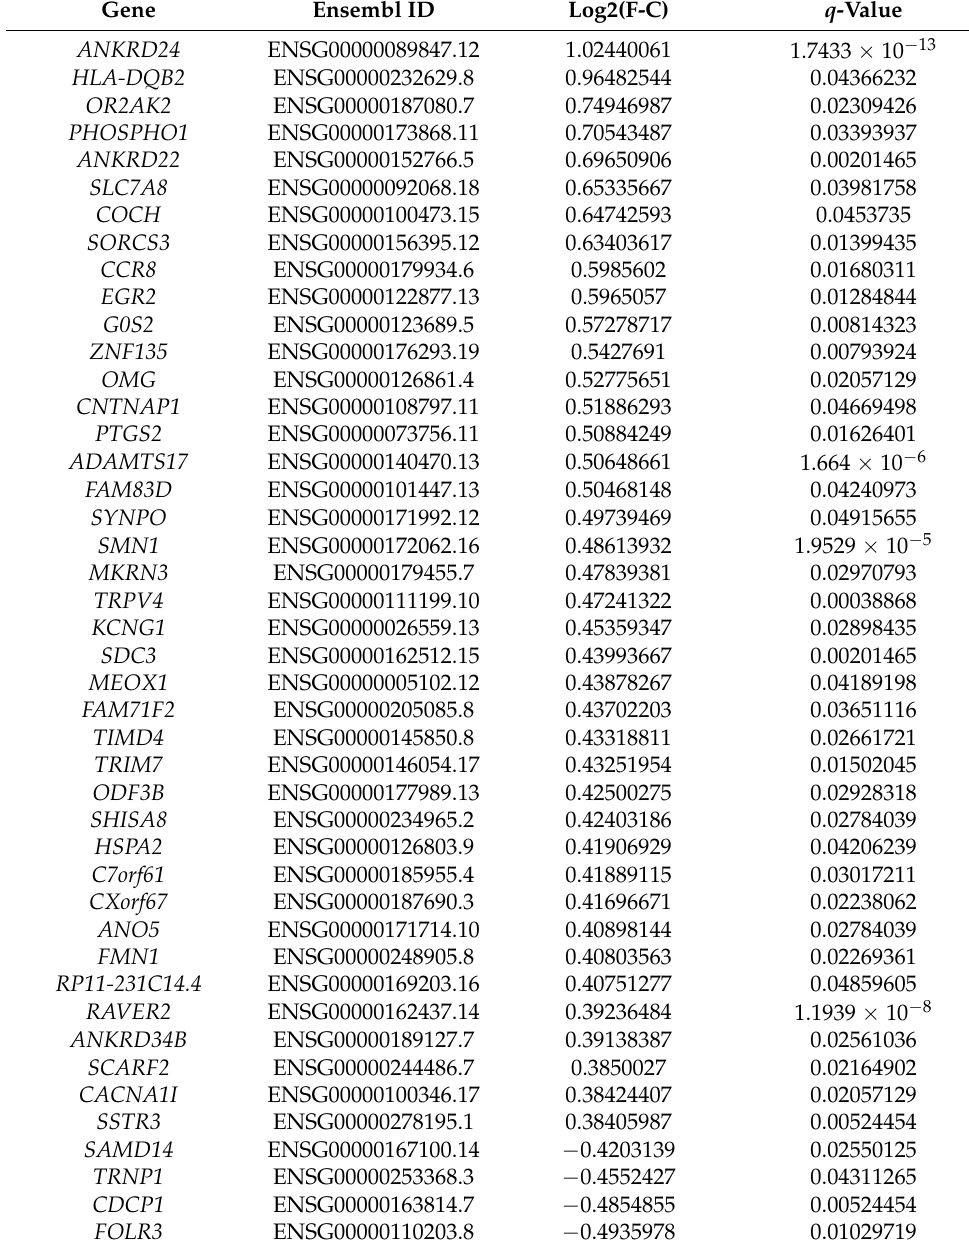
Table 2. Differentially expressed genes identified in the discovery cohort